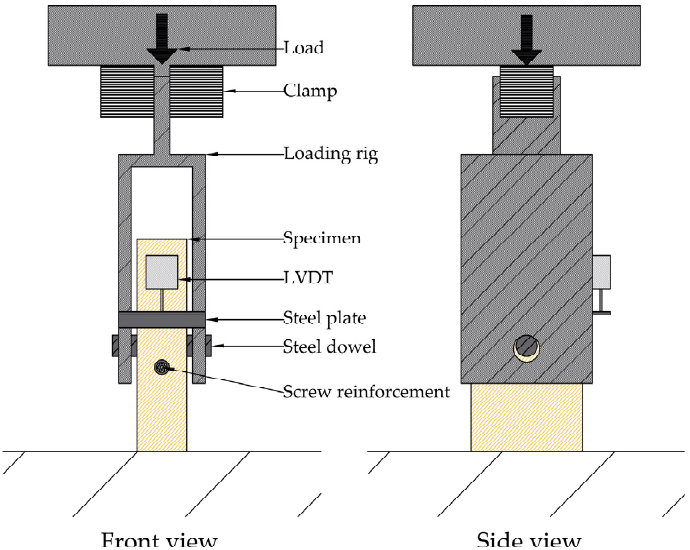
Figure 2. Embedment-strength test set-up. Table 1. Summary of each group in the embedment-strength test [31].